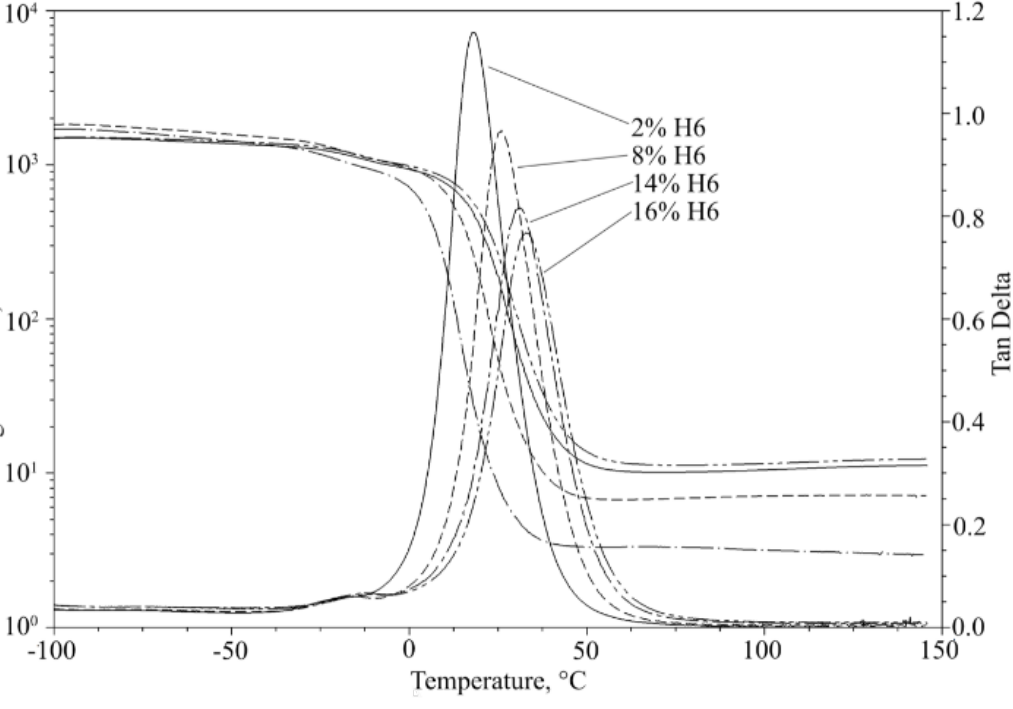
Figure 5. Storage modulus (left axis, rounded step curves) and 'tan delta' (right axis, peaked curves) of H6 composites. See Figure 4 caption for other